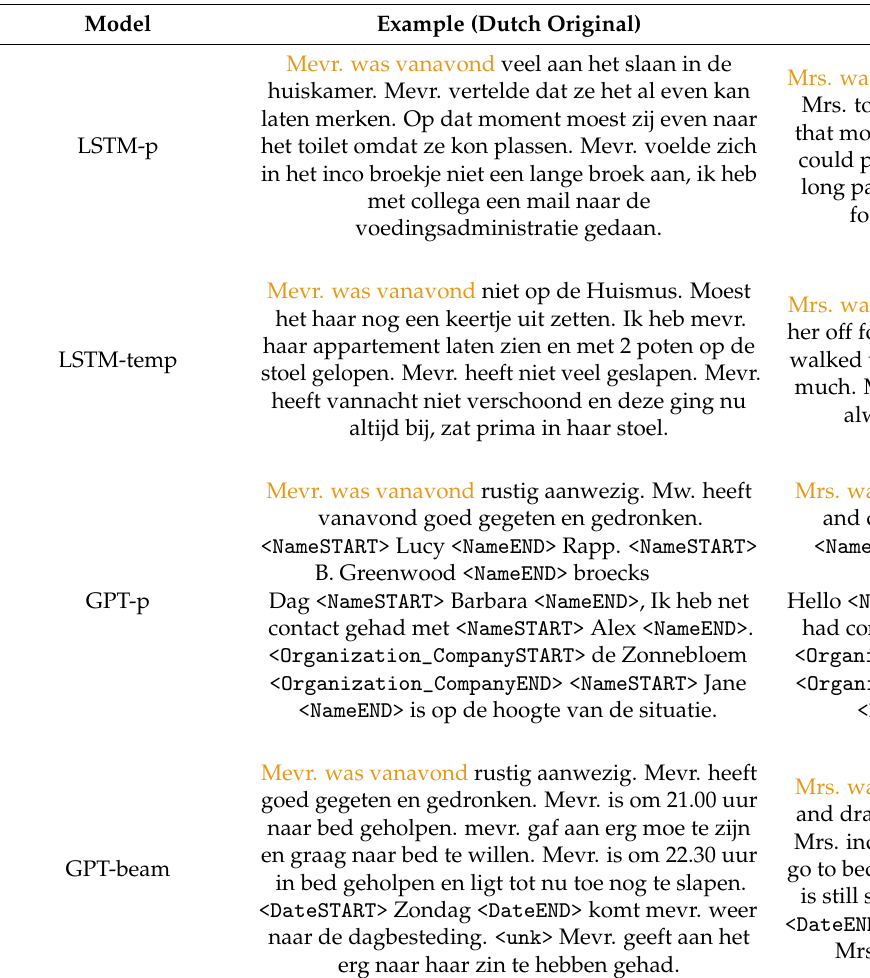
Table A3. Example documents generated by each method with manual English translation. For all examples, we used the same input prompt “Mevr. was vanavond”, which translates to “Mrs. was [...] tonight”. We transformed <PAR> back into line breaks, but otherwise left in-text annotations as they were